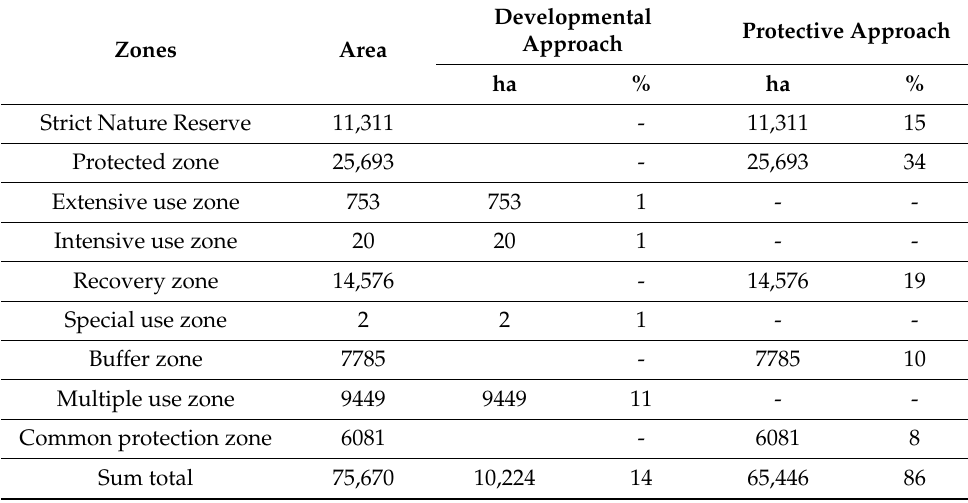
Table 8. Identified zones in the Jajrud Protected